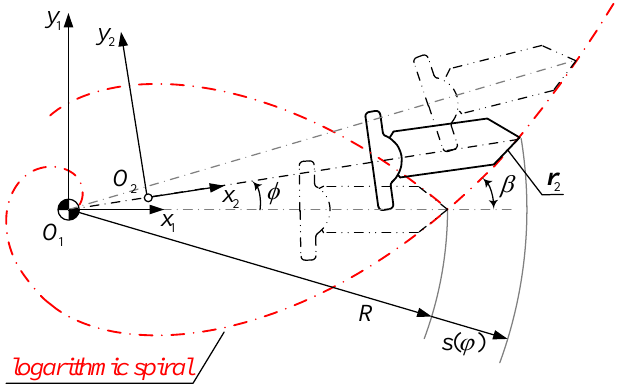
( c ) Figure 4. Logarithmic spiral. ( a ) equiangularity; ( b ) evolute; ( c ) similarity. 3.1.2. Logarithmic Spiral Conjugate Tooth Profile For ease of description, vector equations of the wave generator cam profile, the tooth profile of the movable tooth and the ring gear are represented by r 1 , r 2 , and r 3 , respectively, and the subscripts correspond to the serial numbers of the components in Figure 1. Suppose that the tooth profile of the movable tooth is a known logarithmic spiral and is utilizing the envelope method to calculate the conjugate tooth profile of the ring gear. As shown in Figure 5, a fixed coordinate system O 1 - x 1 y 1 is located at the rotation cen- ter of the wave generator, and a follow-up coordinate system O 2 - x 2 y 2 is connected to the